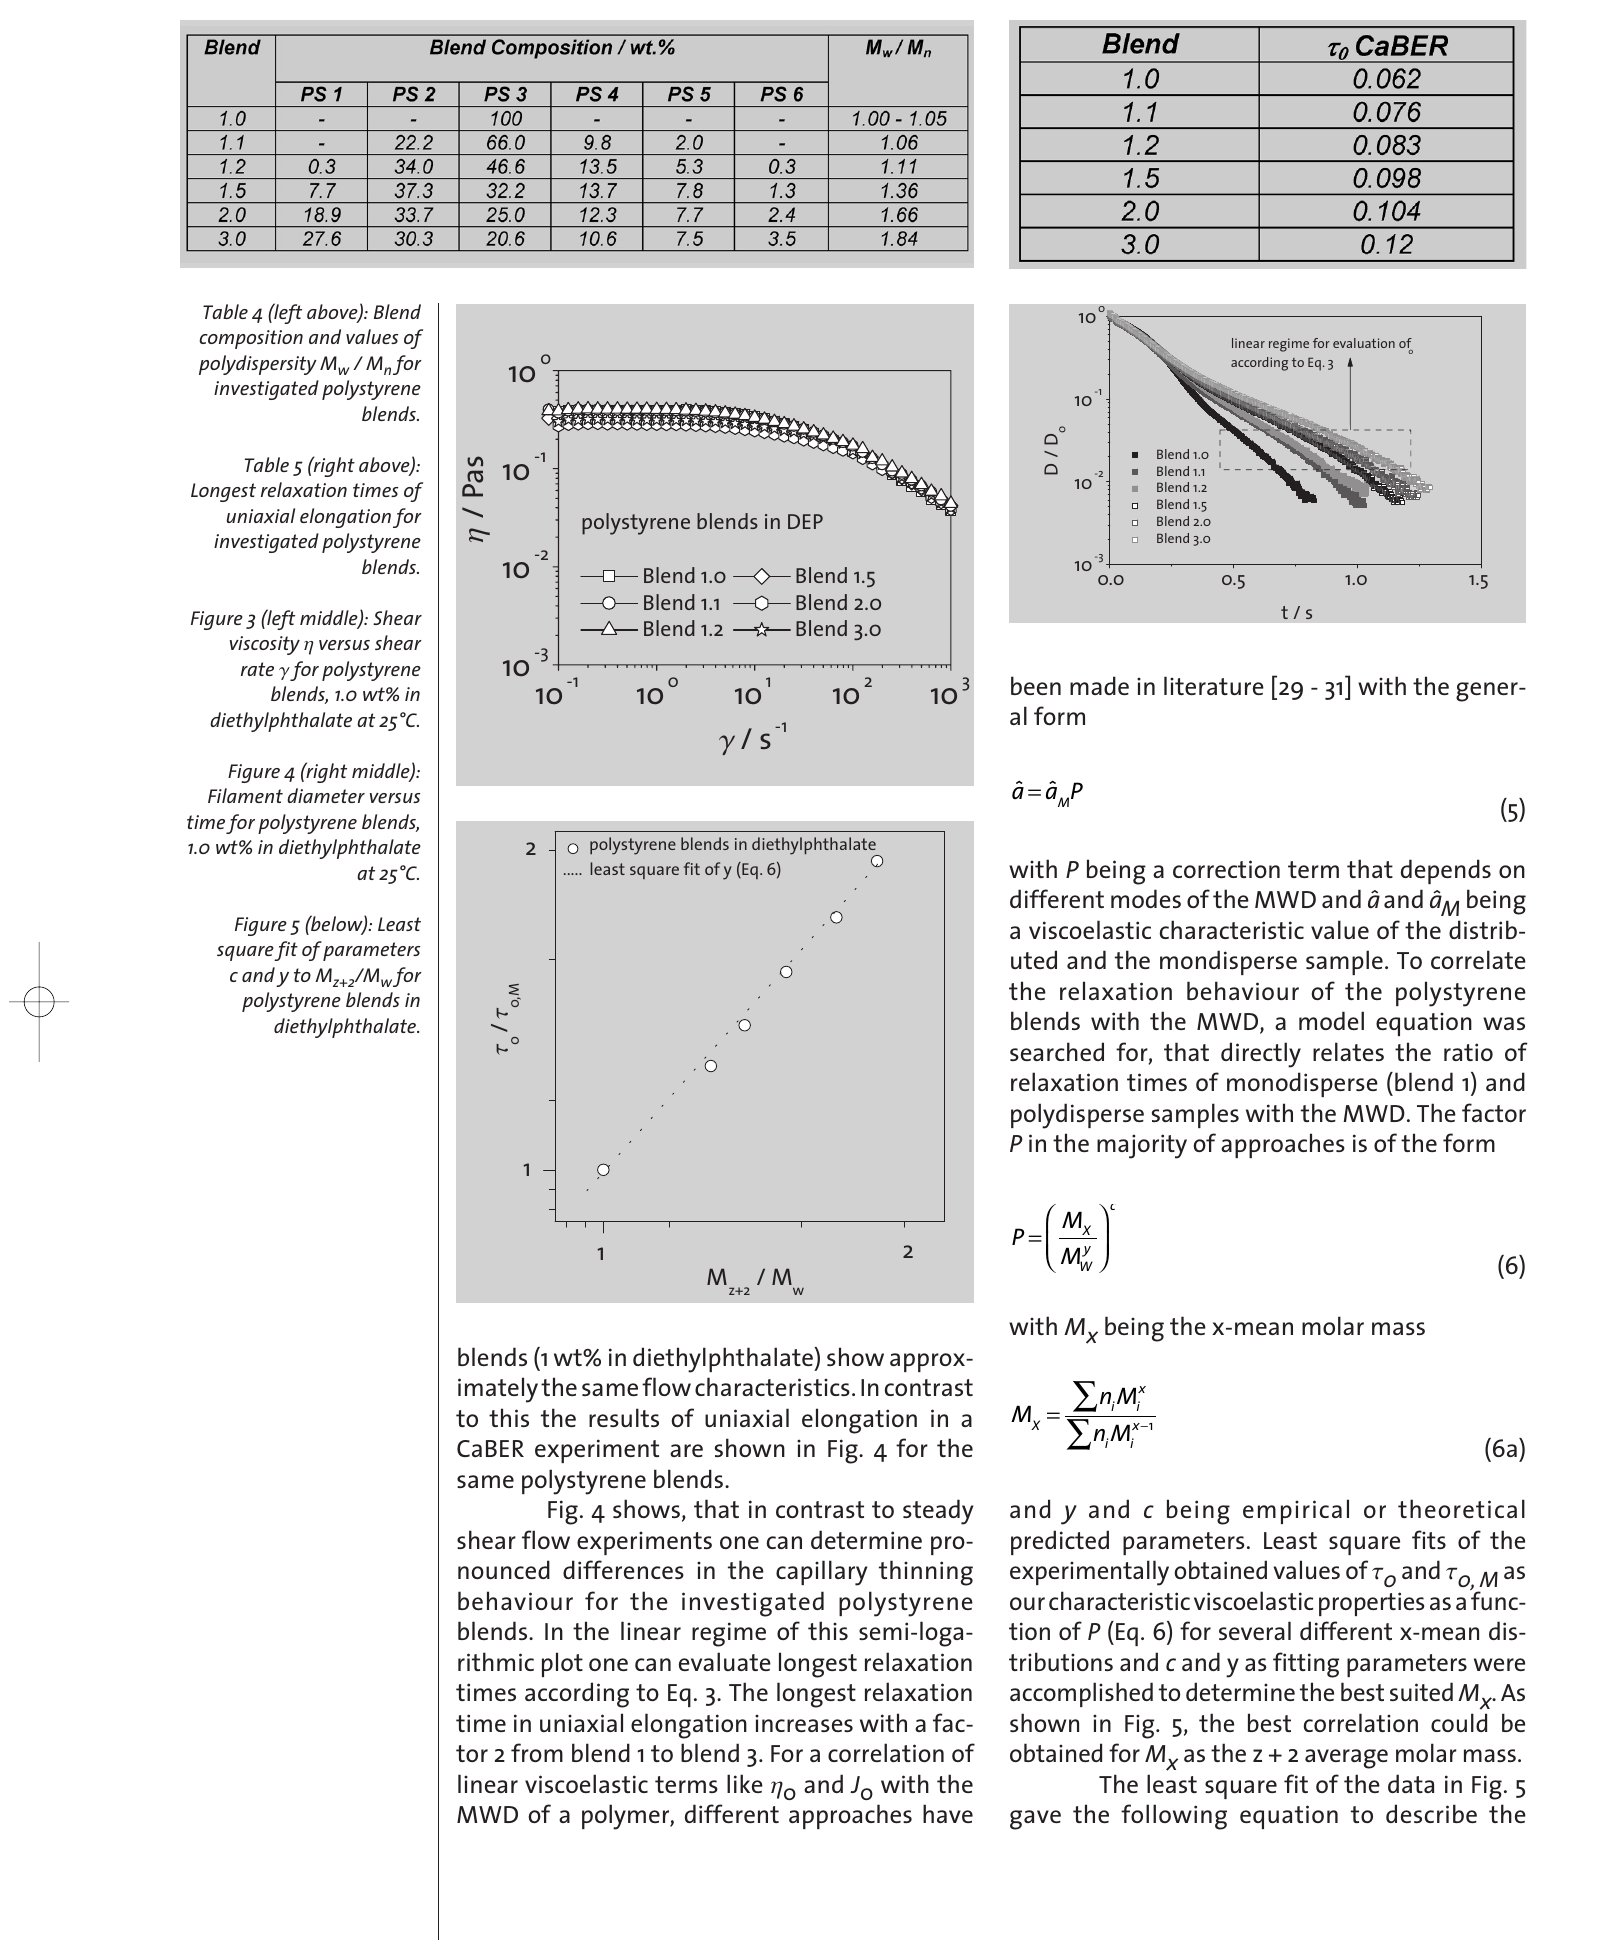
Table 4 (left above): Blend composition and values of polydispersity M w / M n for investigated polystyrene blends. Table 5 (right above): Longest relaxation times of uniaxial elongation for investigated polystyrene blends. Figure 3 (left middle): Shear viscosity h versus shear rate g for polystyrene blends, 1.0 wt% in diethylphthalate at 25°C. Figure 4 (right middle): Filament diameter versus time for polystyrene blends, 1.0 wt% in diethylphthalate at 25°C. Figure 5 (below): Least square fit of parameters c and y to M z+2 /M w for polystyrene blends in